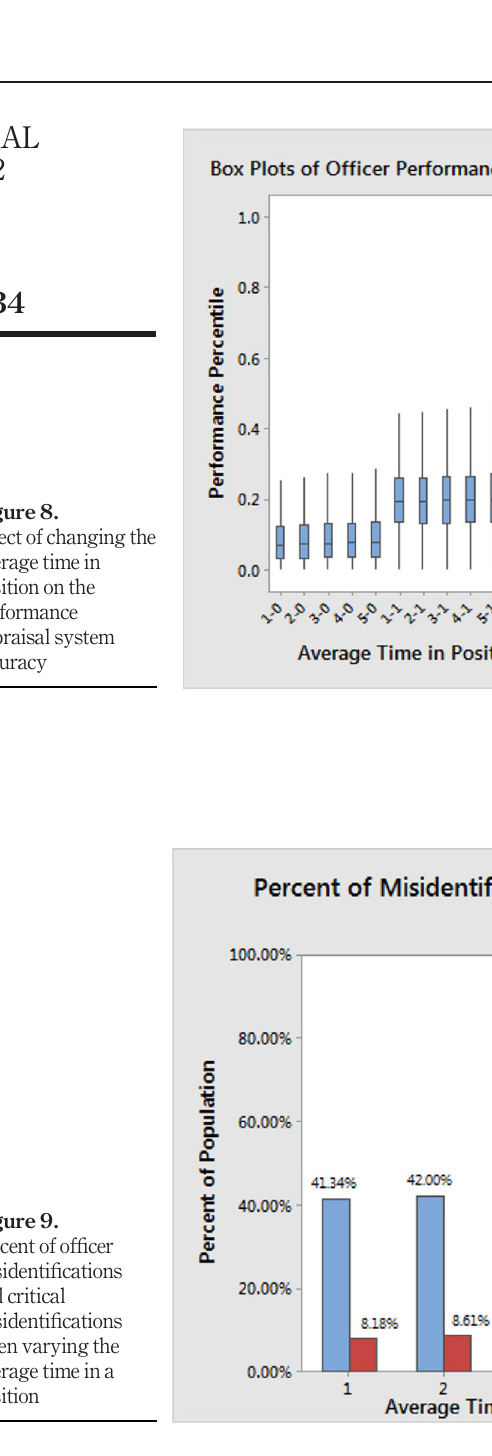
Figure 9. Percent of of fi cer misidenti fi cations and critical misidenti fi cations when varying the average time in a